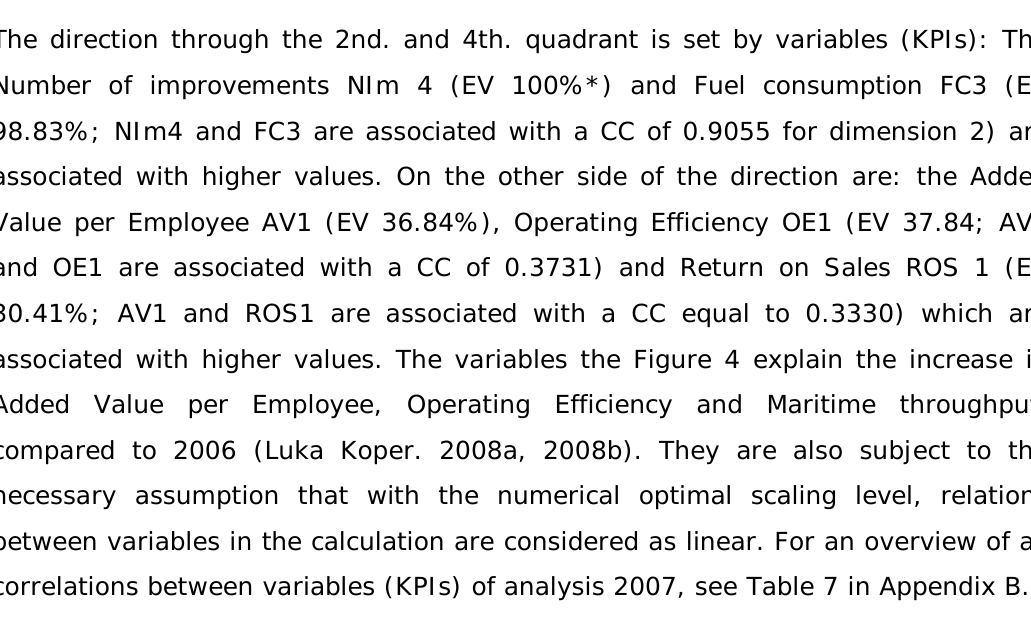
Figure 4. “Component Loadings 2007 (Numerical and Multiple